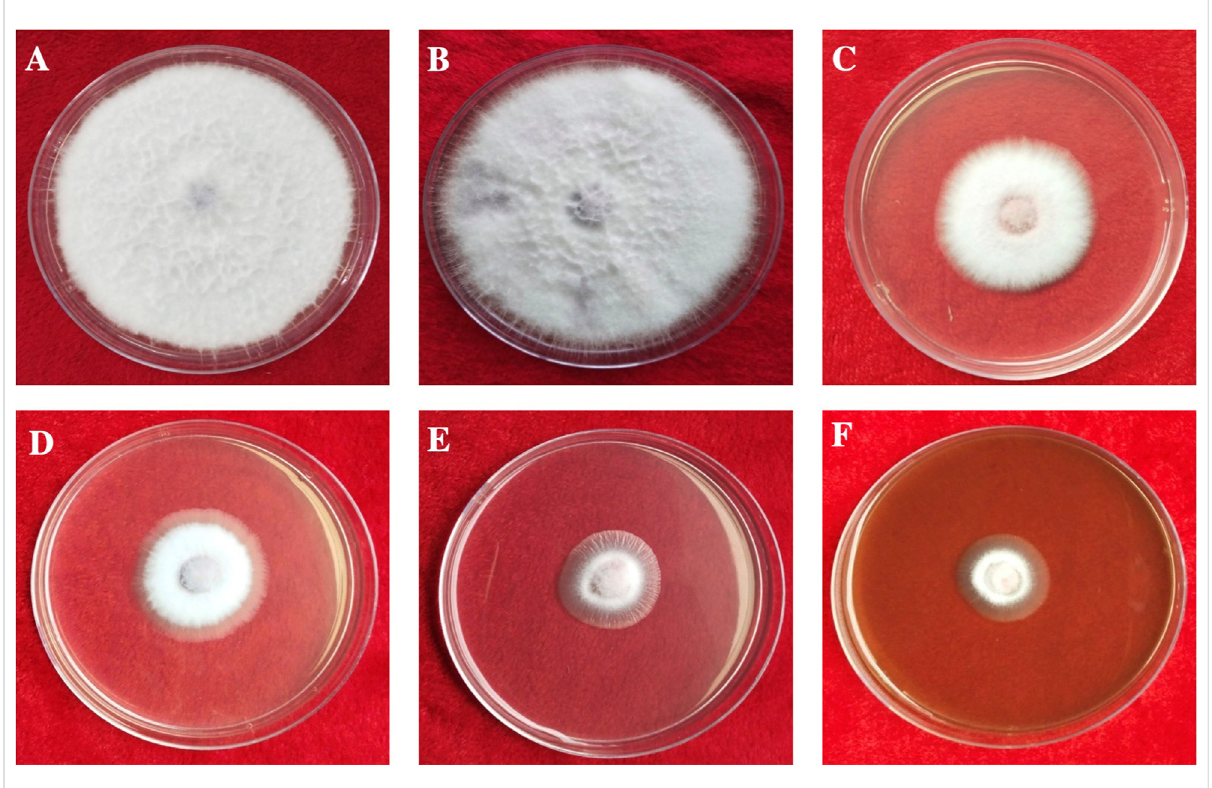
FIGURE 8 In vitro antifungal activity of synthesized AgNPs. (A) Control. (B) Plant extract. (C) AgNO 3 . (D – F) 50, 100, and 150 µg/ml of